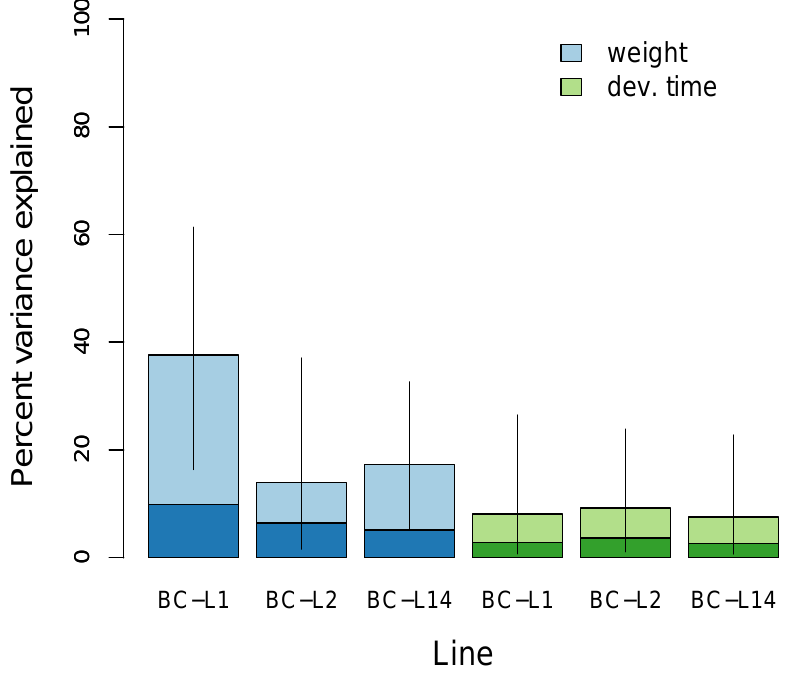
Figure 3. Bayesian estimates of the percent of variance in weight and development time explained (PVE) by the additive effects of genetic variants as captured by the SNP dataset for each of the three back-cross lines (BC-L1, BC-L2, and BC-L14). Colored bars denote point estimates of the PVE, and vertical lines denote 95% equal-tail probability intervals. The darker portion of each bar indicates a point estimate of the portion of the PVE attributable to genetic variants with individually measurable